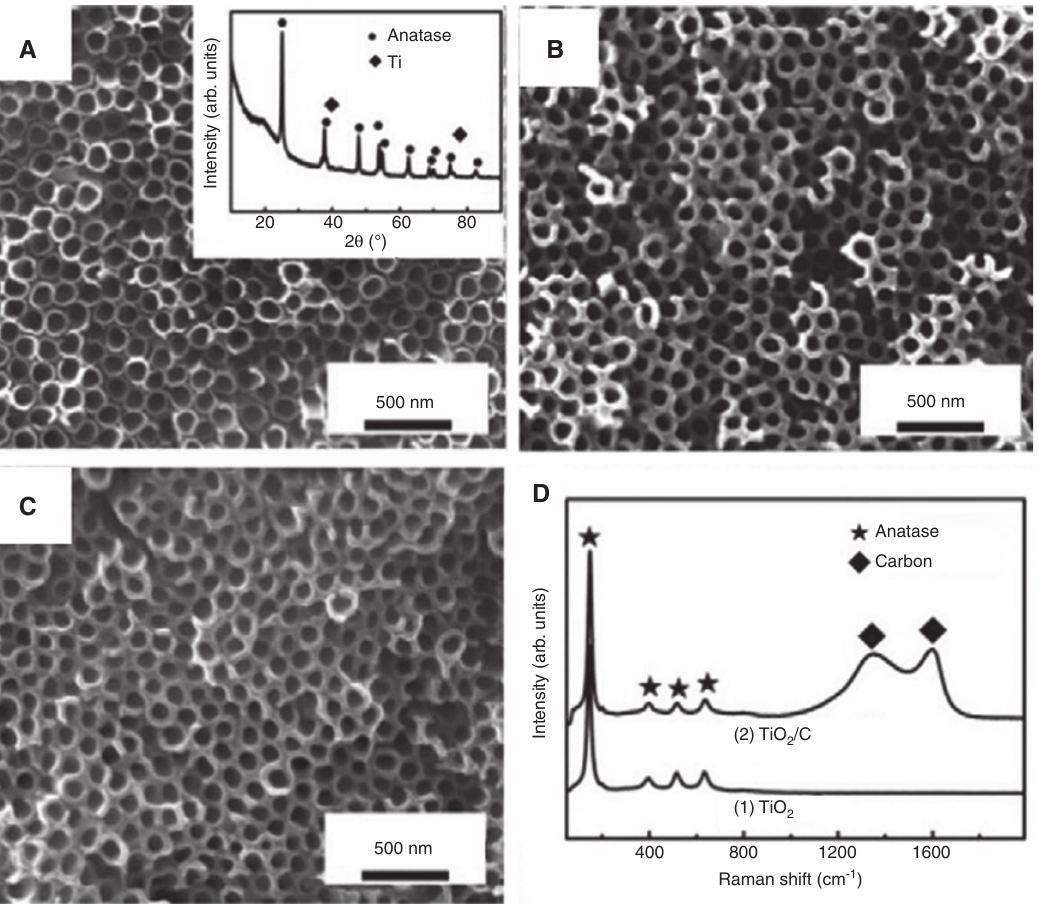
NTAs annealed in air at 450 ° C (A), hydrothermal treated TiO Figure 11: SEM images of TiO 2 sequently annealed sample under N at 700 ° C for 3 h (C). The Raman spectra of the samples (A) and (C) are shown in (D). Reproduced from 2 Ref. [126] with permission. Copyright